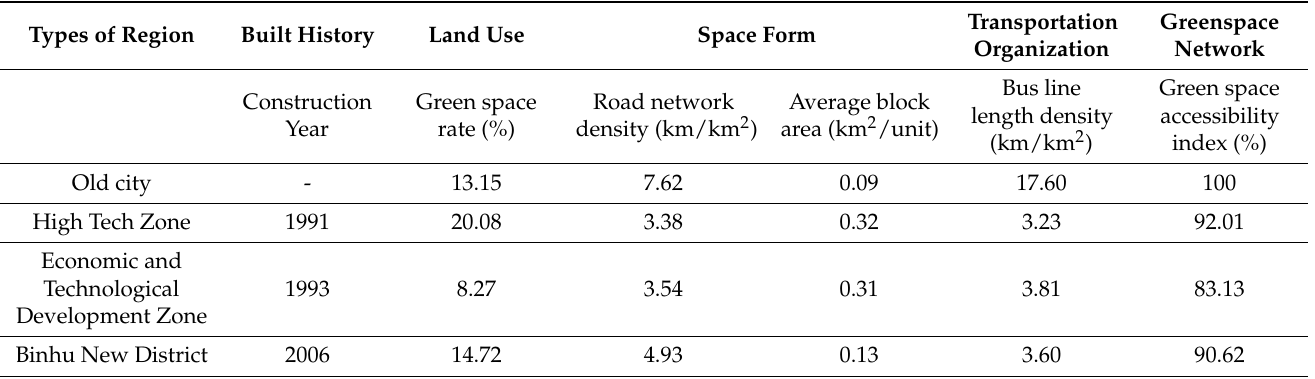
Table 6. Comparison of city-level built